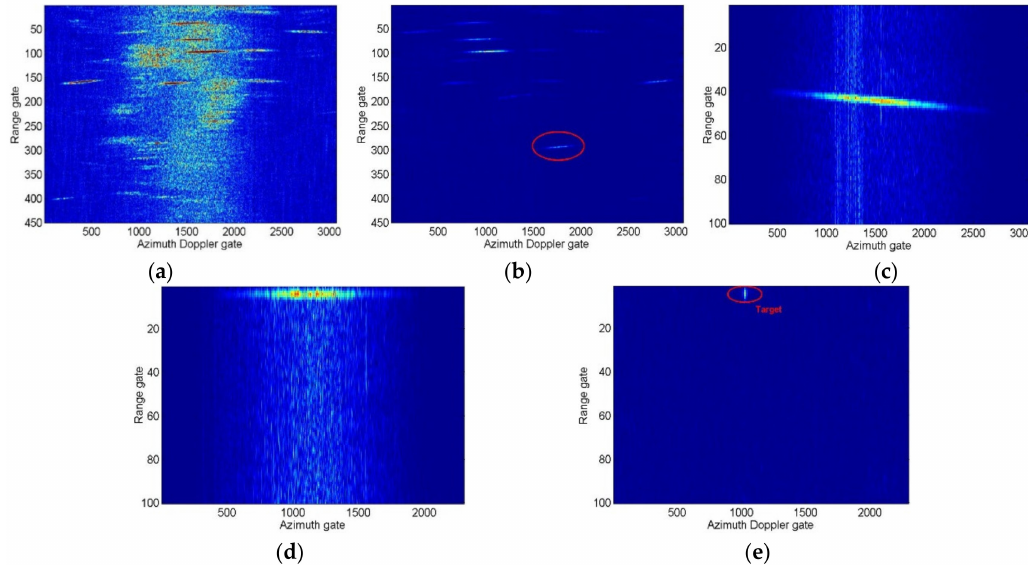
Figure 9. Refocusing results for a ground maneuvering target in a real SAR system. ( a ) Imaging result of ground maneuvering targets before clutter suppression. ( b ) Result after clutter suppression. ( c ) Moving trajectory of an interested target. ( d ) Result after DPT and KT operations. ( e ) Focusing result of the presented